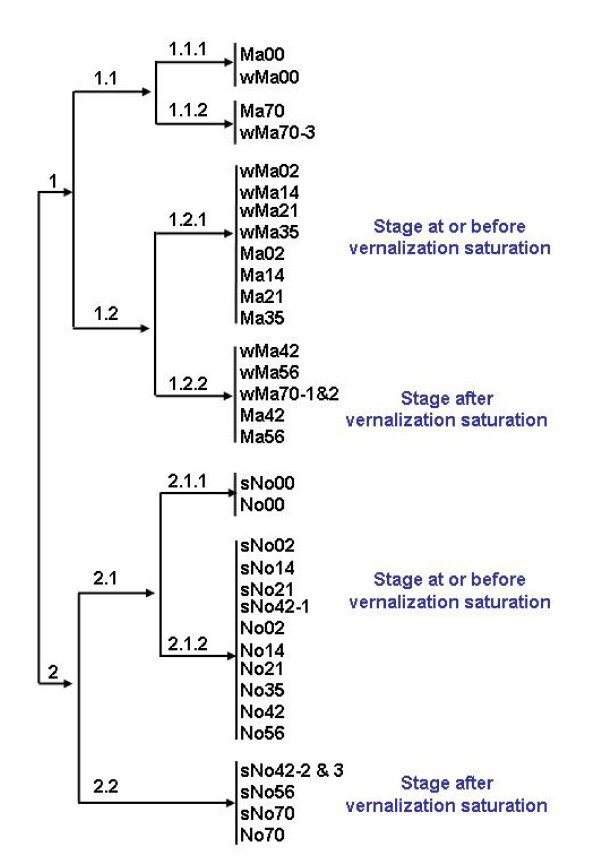
Correlation of variance of gene expression between samples. Dendogram for the first 2 levels of branching of a 96 × 96 sample comparison matrix (see Additional file 1).